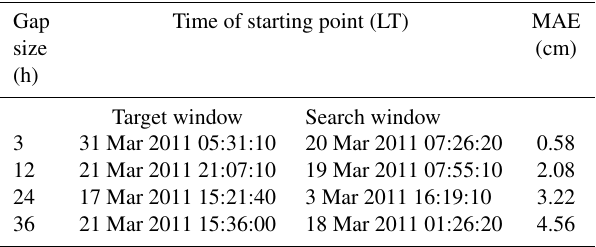
Table 3. Examples of a gap-filling algorithm. The information of window and the mean absolute error (MAE) between the predicted data and measured data are